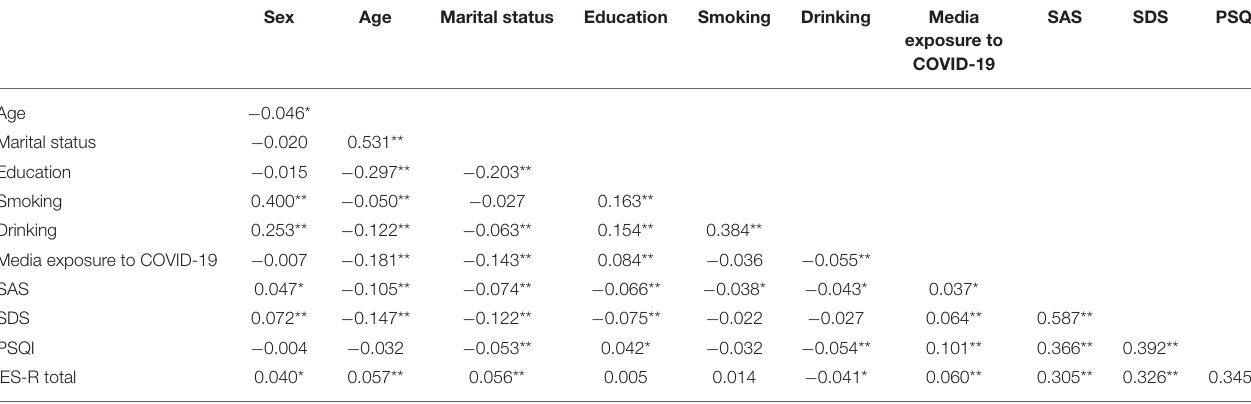
TABLE 6 | Correlations between demographic characteristics and clinical variables of non-depressed group. Sex Age Marital status Education Smoking Drinking Media